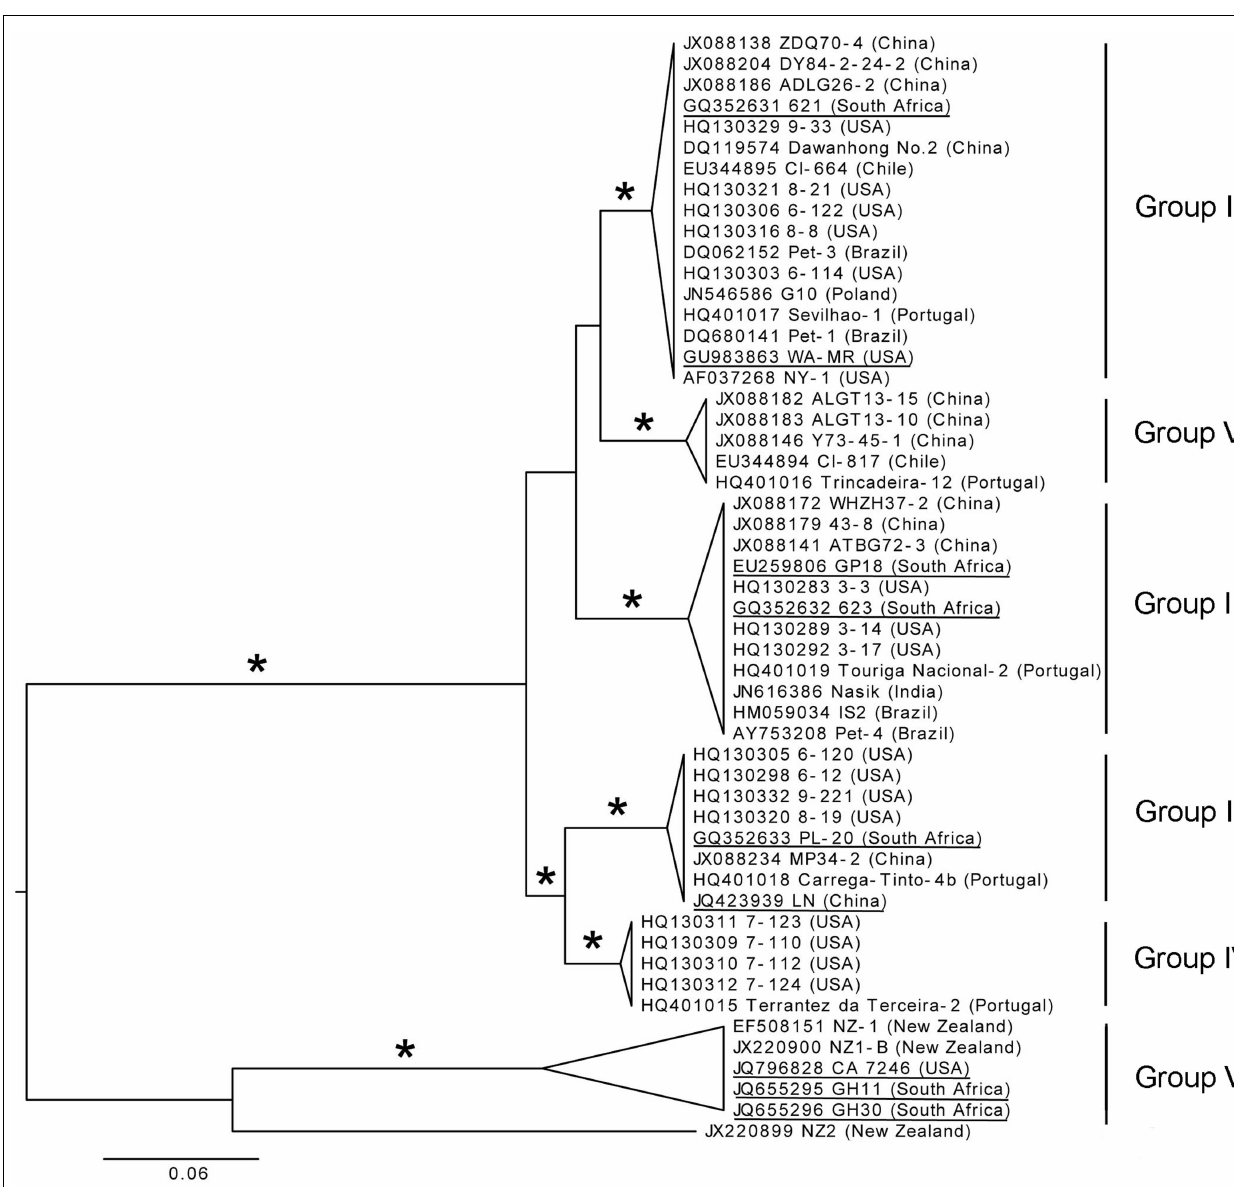
rooted for presentation and asterisks indicate ≥ 75% branch support with all three methods. Accession number, isolate name, and country where samples were collected are shown; fully sequenced genomes are underlined for reference.The phylogenetic analysis was performed with PAUP* (Swofford, 2003) and image generated with FigTree (Rambaut,